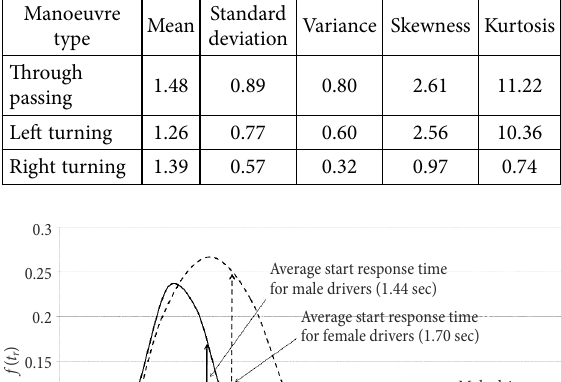
Table 5. Descriptive statistics of left, right turning